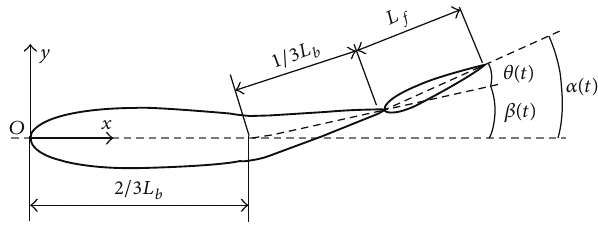
Figure 1: Coordinate for the fish motion.